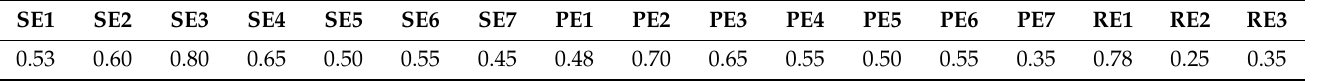
Table 6. Estimated probability of event occurrence matrix P